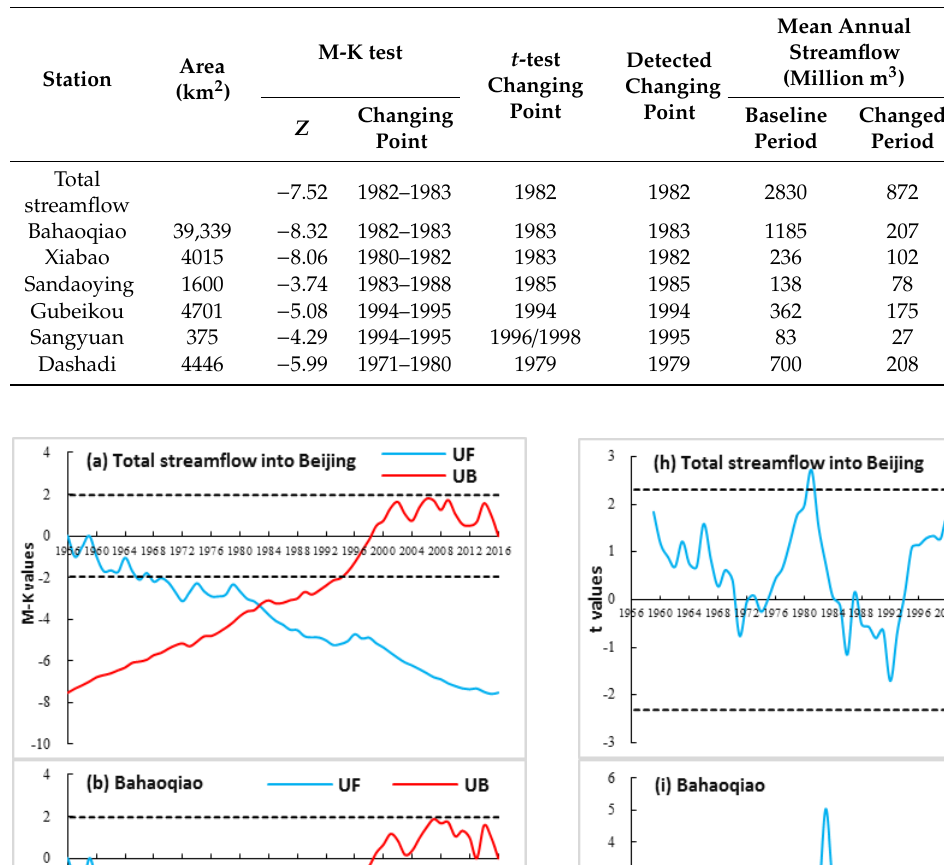
Table 1. Trends and changing points of the annual streamflow.